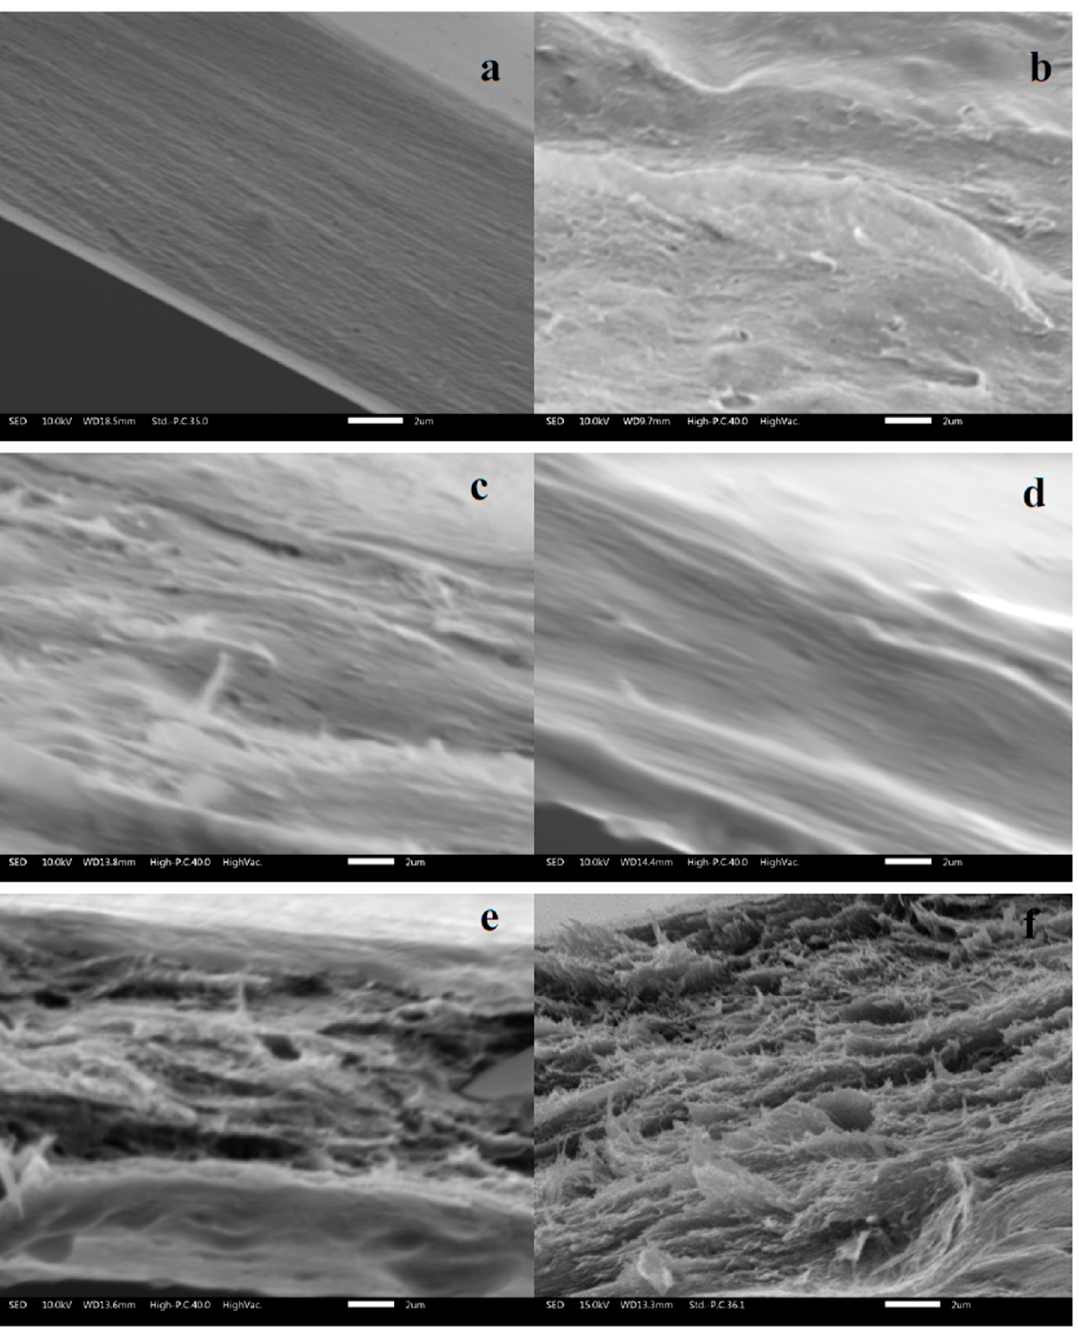
Figure 3. SEM images of ( a ) CA film, ( b ) CA/1.25% RSNF, ( c ) CA/2.5% RSNF ( d ) CA/5% RSNF, ( e ) CA/7.5% RSNF, and ( f ) CA/10% RSNF. The scale bar is 2